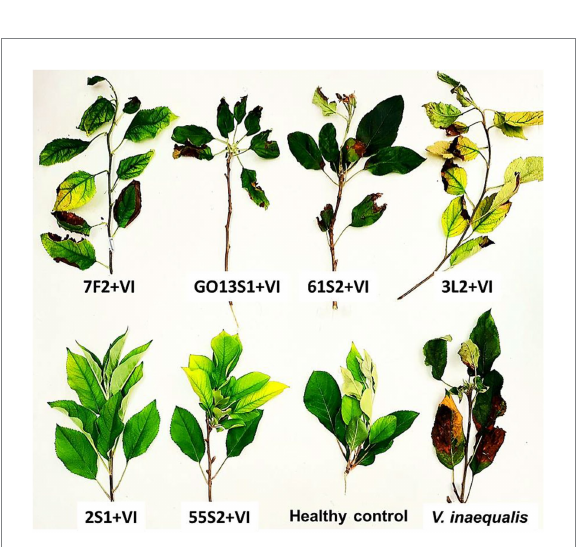
FIGURE 12 Effect of endophyte isolates on development of symptoms caused by Venturia inaequalis on apple leaves at 18–20 ° C after 1 month of pathogen inoculation in greenhouse. (Treatments: Aureobasidium microstictum 7F2, Acremonium sclerotigenum GO13S1, Fusarium lateritium 61S2, Chaetomium globosum 3 L2, Chaetomium globosum 2S1, Coniochaeta endophytica 55S2, VI: Venturia inaequalis